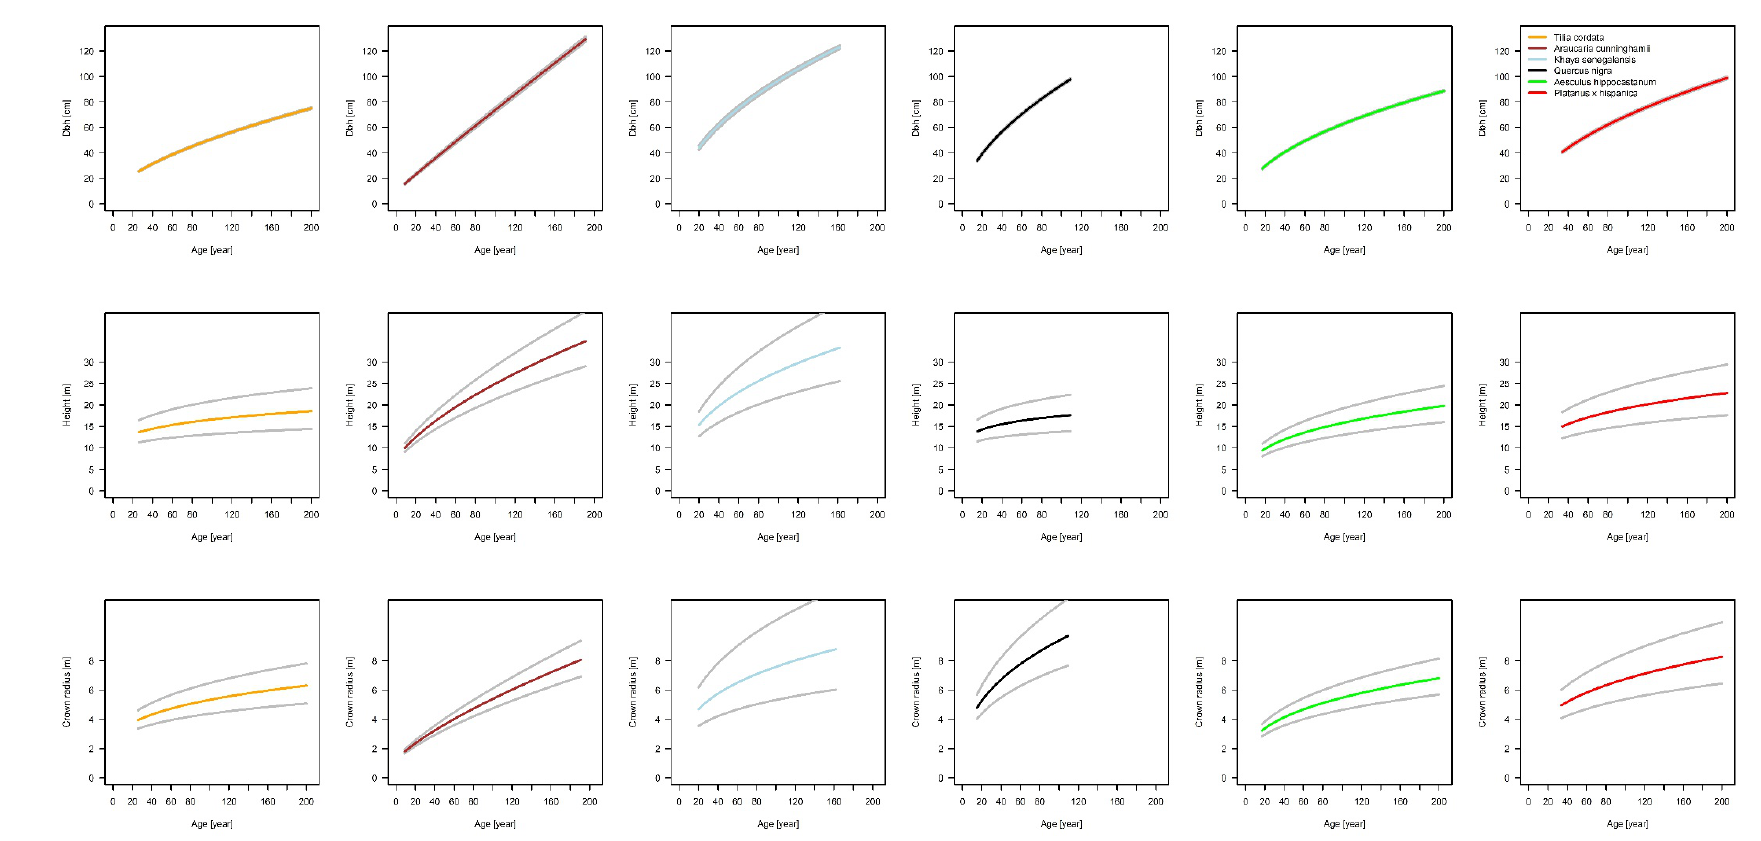
Figure A1. Allometric relationships for diameter at breast breast height (upper line), tree height (middle line) and crown radius (lower line) based on allometric model parametrizations for all six tree species (based on values of Table 3, 4 and 5). The coloured lines show the best-fit lines, and the grey lines indicate the visualized standard error of β 1.